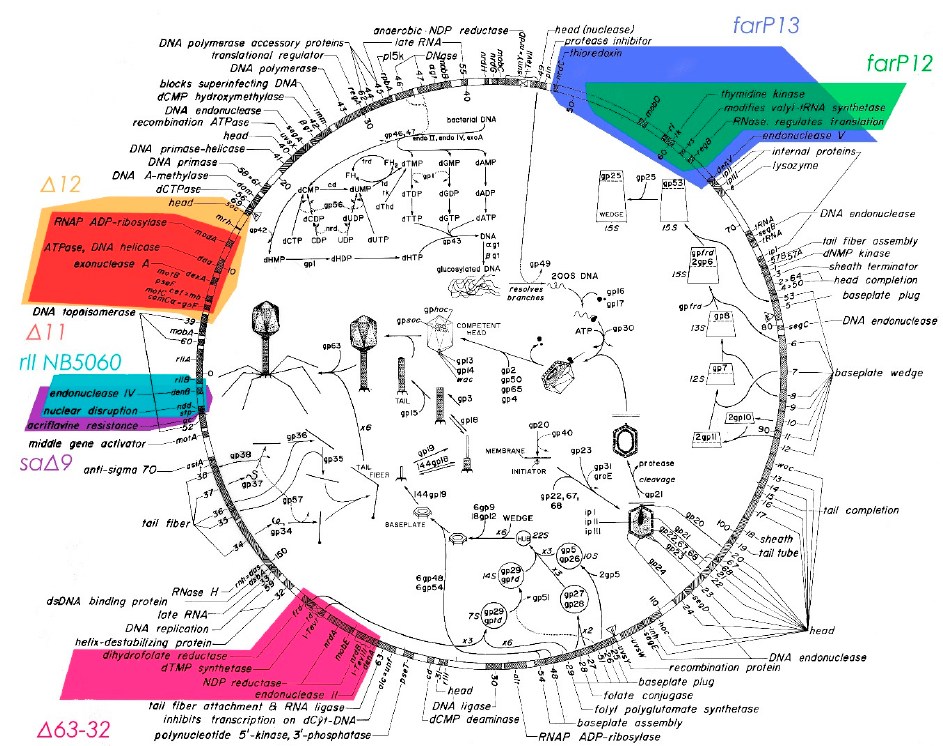
Figure 1. Genomic and functional map of bacteriophage T4: This map, tying various aspects of phage production to the relevant genes, is updated from the frontispiece by B. Guttman and E. Kutter for the 1994 ASM “Bacteriophage T4” book, in which the completed sequencing of the T4 genome was presented [5]. The mainly-structural late genes, beginning with gene 3 , are almost all transcribed in the clockwise direction on this map, while all of the genes expressed early and in the middle mode are transcribed in the counter-clockwise direction, including all of the genes in the big deletable regions that are indicated in color here.